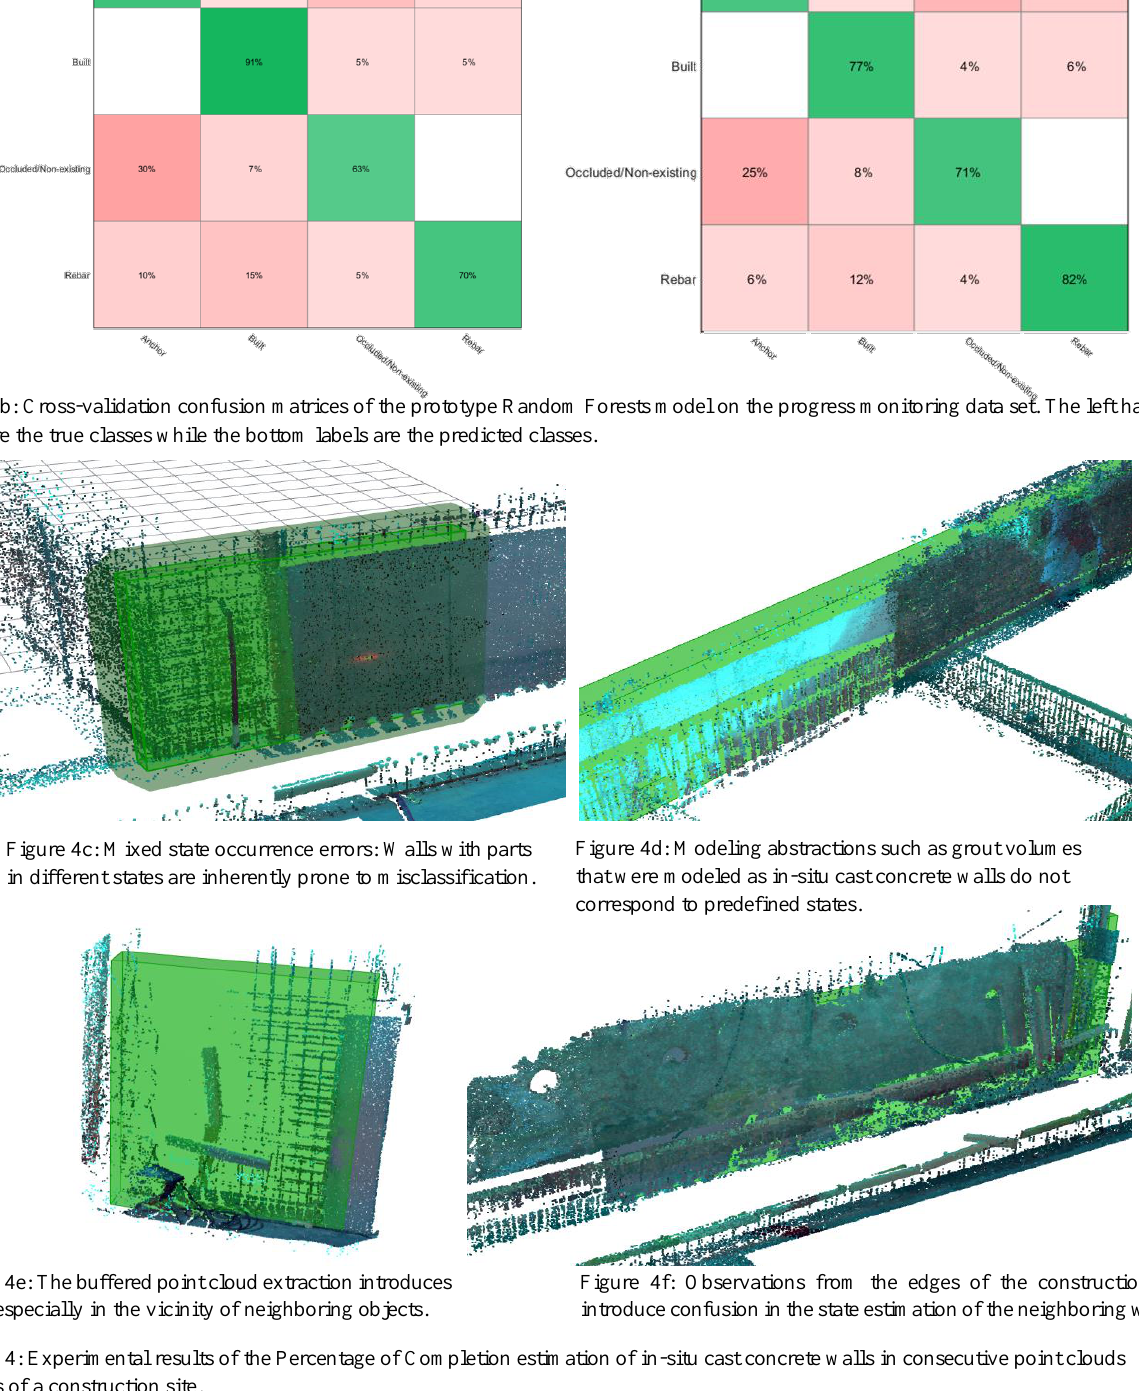
Figure 4f: Observations from the edges of the construction pit introduce confusion in the state estimation of the neighboring walls.